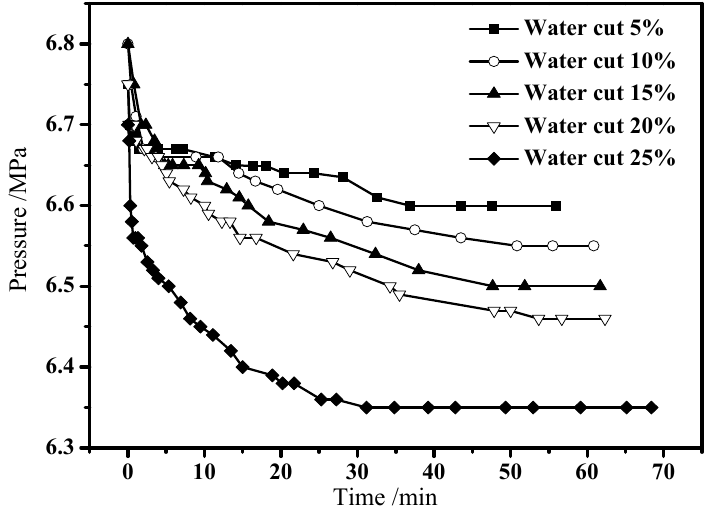
Figure 6. Variation of pressure with time in the process of natural gas hydrate formation in